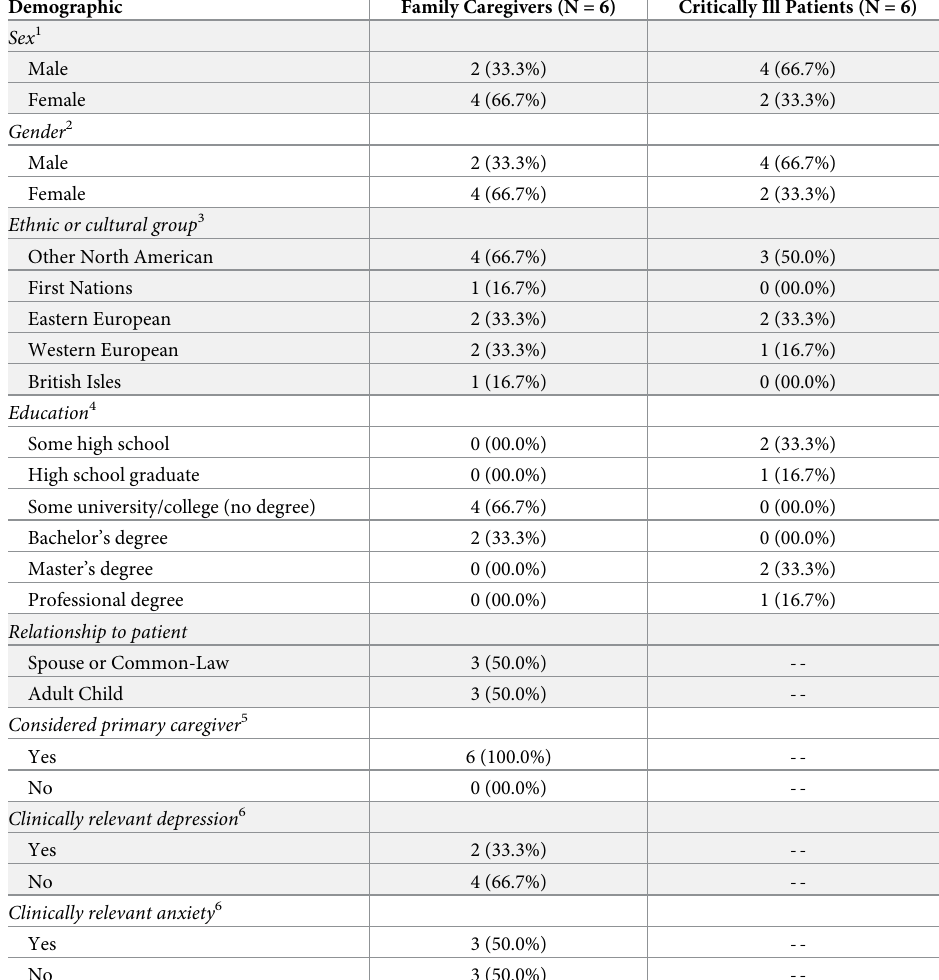
Table 1. Demographics of designated family caregiver participants and their critically ill loved one admitted to an intensive care unit during the COVID-19